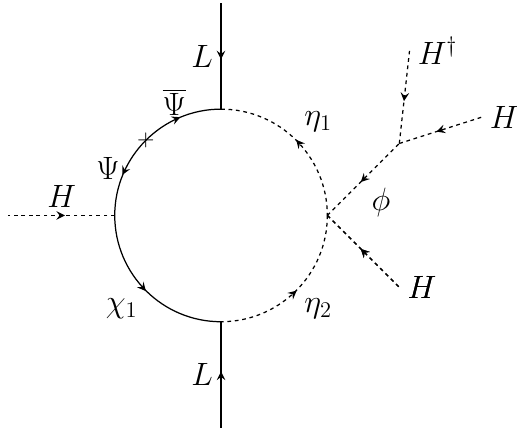
Figure 12 . Example of one of the most minimal models that one can construct at d = 7 1-loop order with SU(2) L representations up to 5-plets generated from the diagram T13-i in (cid:12)gure